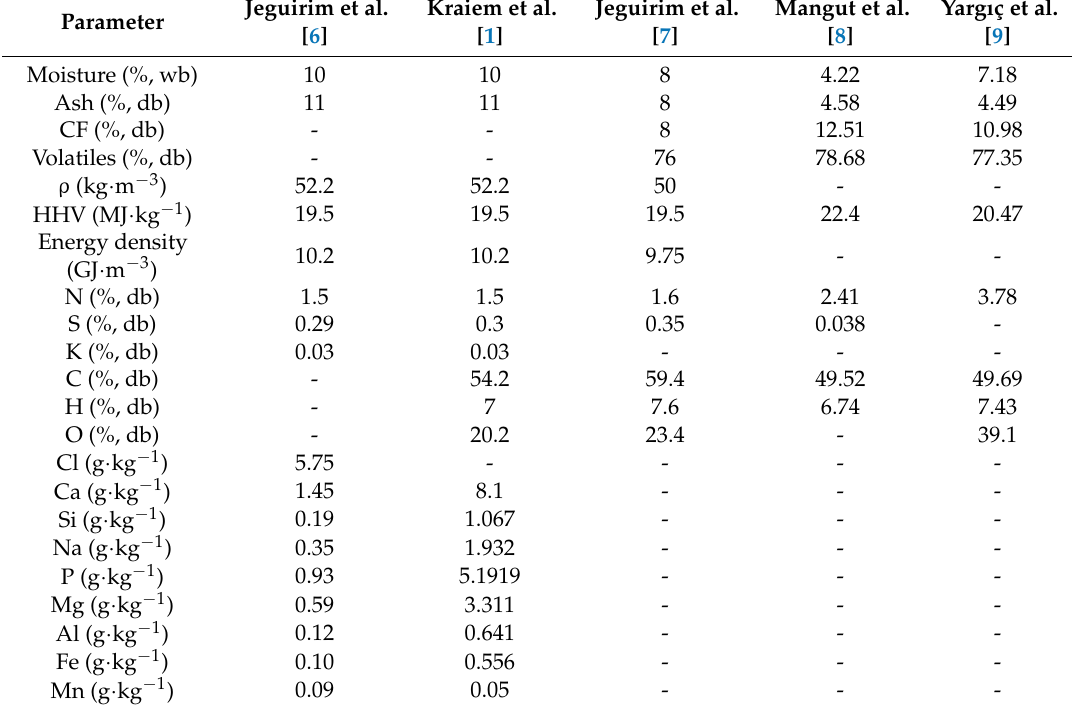
Table 1. Physical and chemical properties of tomato